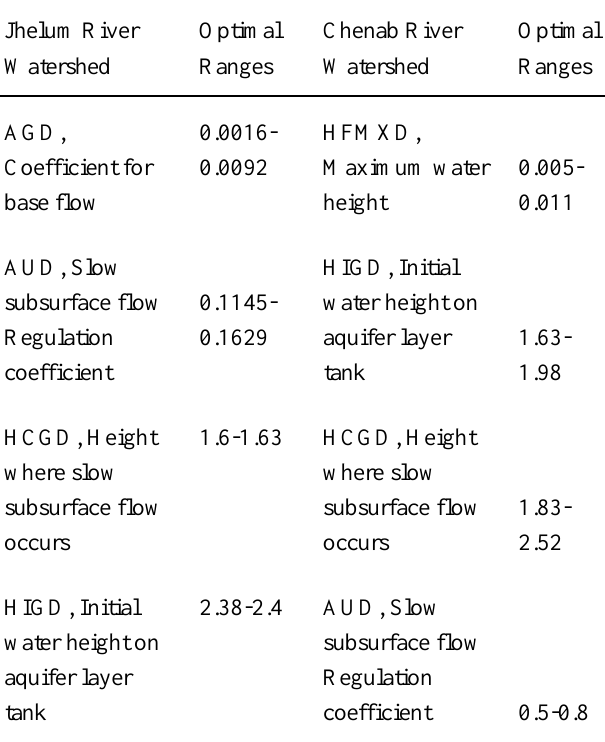
Optimized ranges for highly ranked parameters in Jhelum river basin and Chenab river basin